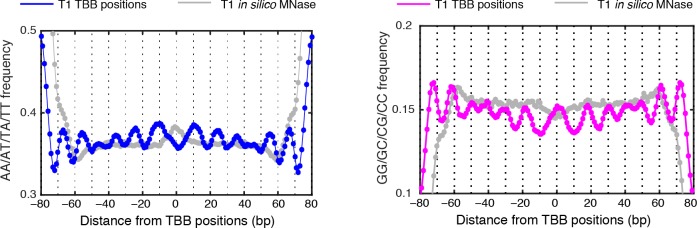
MNase-digestion correction for dinucleotides frequency of TBB positions.Dinucleotide frequency for TBB positions from experiment T1(blue, pink) and the nucleosome positions determined from the simulated MNase digestion data set (gray).